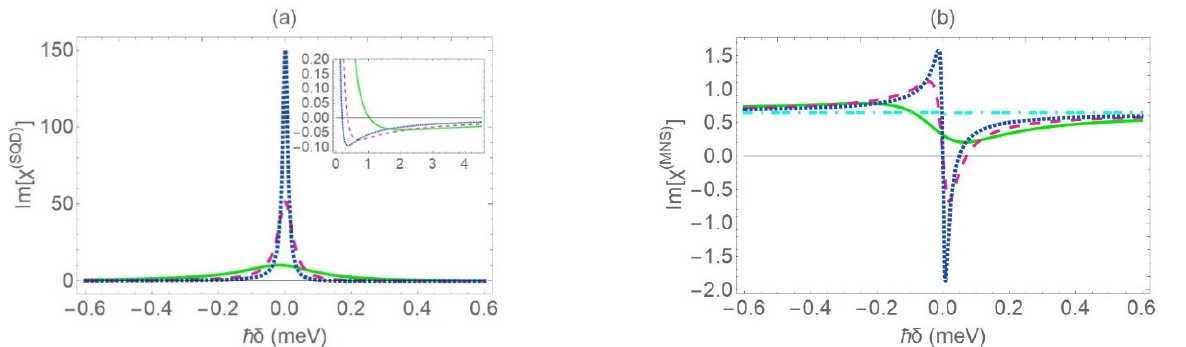
Figure 4. The linear absorption spectra for the SQD ( a ) and the MNS ( b ), for different values of the center ‐ to ‐ center distance (green solid curve: R (cid:3404) 11.5nm , pink dashed curve: 13.5nm , blue dotted center-to-center distance (green solid curve: R = 11.5 nm, pink dashed curve: 13.5 nm, blue dotted curve: 15.5nm and turquoise dashed ‐ dotted curve: 100 nm). The physical parameters take the same curve: 15.5 nm and turquoise dashed-dotted curve: 100 nm). The physical parameters take the same values as in Figure 3, except for the inner radius of the MNS 𝑟 (cid:2869) , which is set equal to 7nm . values as in Figure 3, except for the inner radius of the MNS r 1 , which is set equal to 7